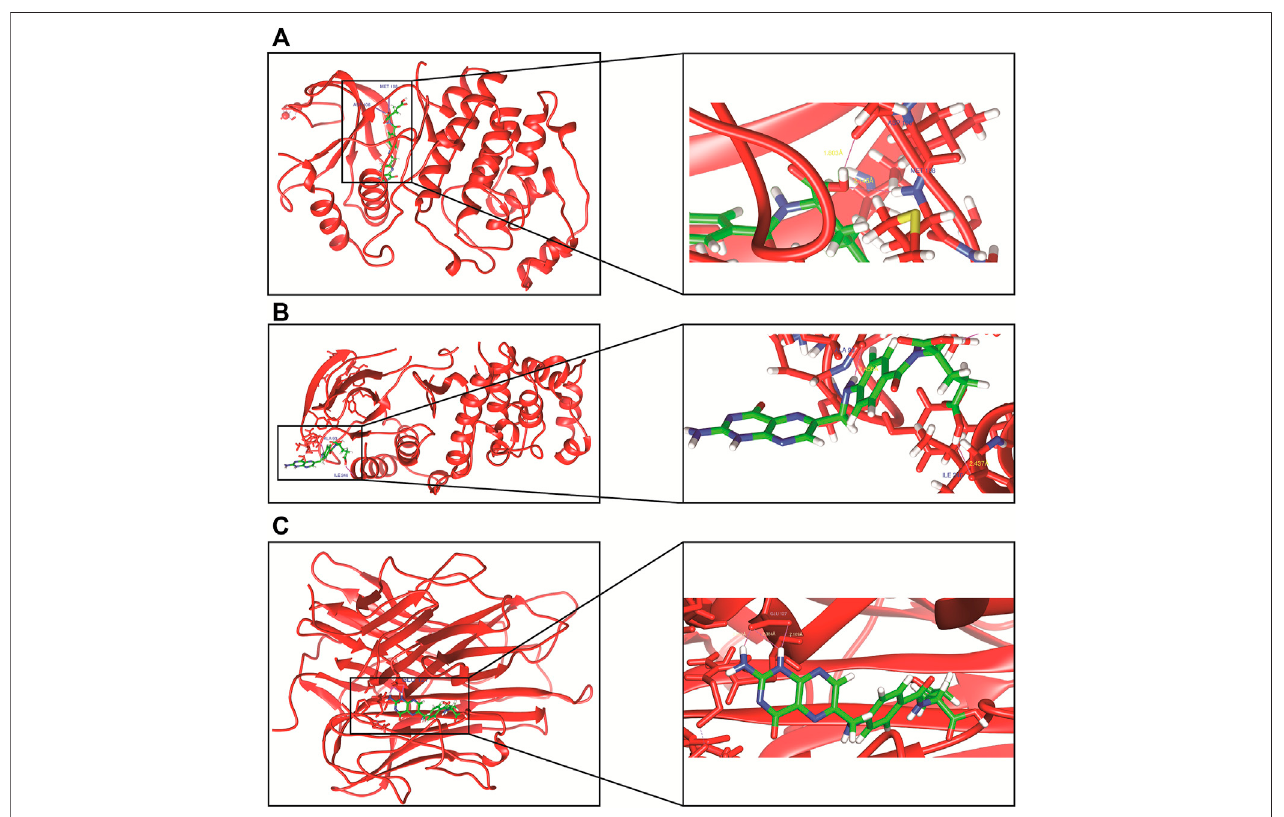
FIGURE 6 | The molecular docking of FA and core targets. (A) FA docking with MAPK1. (B) FA docking with MAPK14. (C) FA docking with TNF- α .